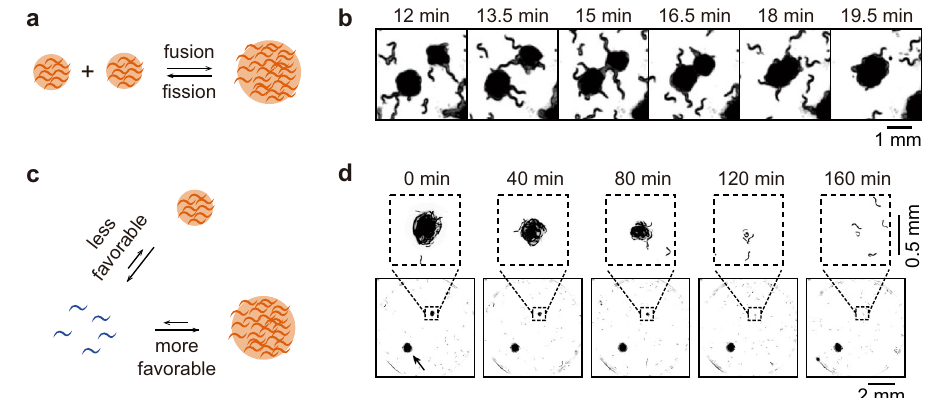
Fig. 5 Spatial coarsening during colony formation. a Fusion of two small colonies to form a larger one. In principle colony fi ssion might occur as well. b An example of colony fusion, from Supplementary Movie 1. c A simple model for Ostwald ripening, where the k − 1 / k 1 is assumed to decrease with colony size. d An example of a small colony that progressively decreases in size and then